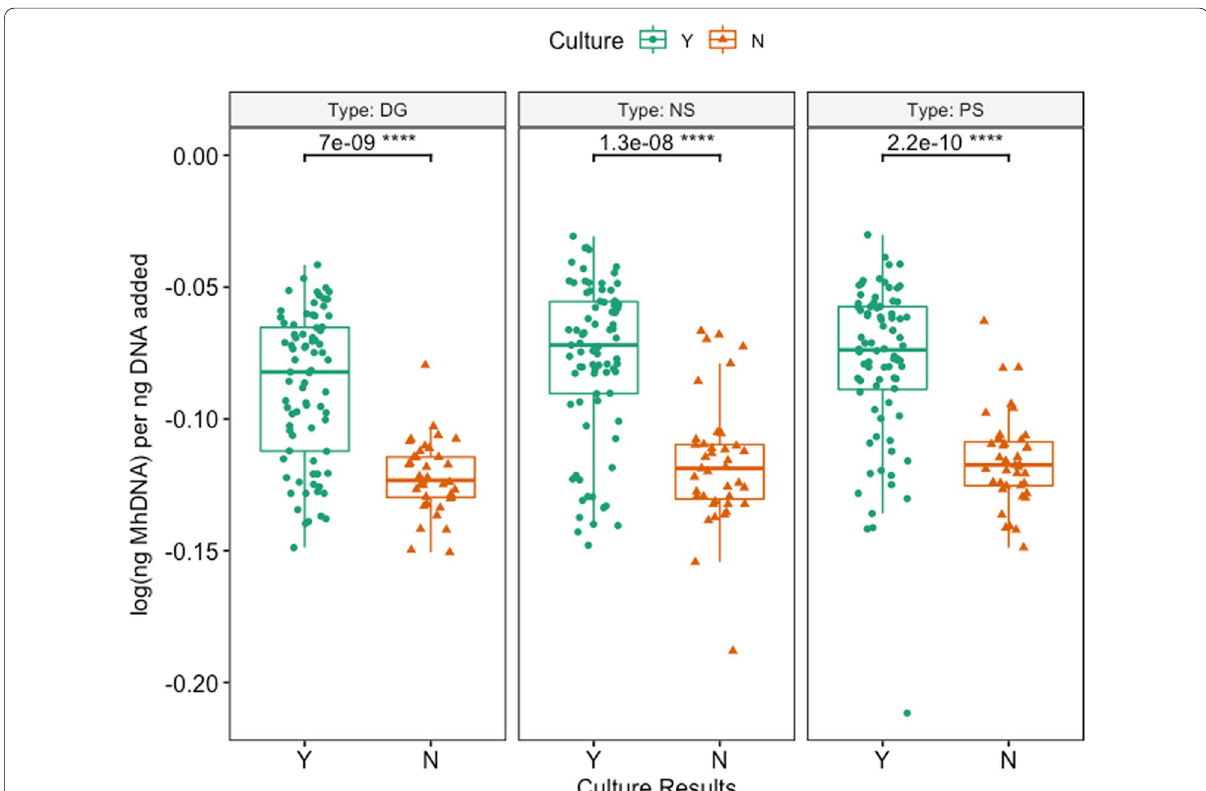
Fig. 5 Box and whisker plots of log(ng Mh DNA) per ng DNA added vs sampling group, separated by Swab Type (Wilcoxon rank-sum test, P <